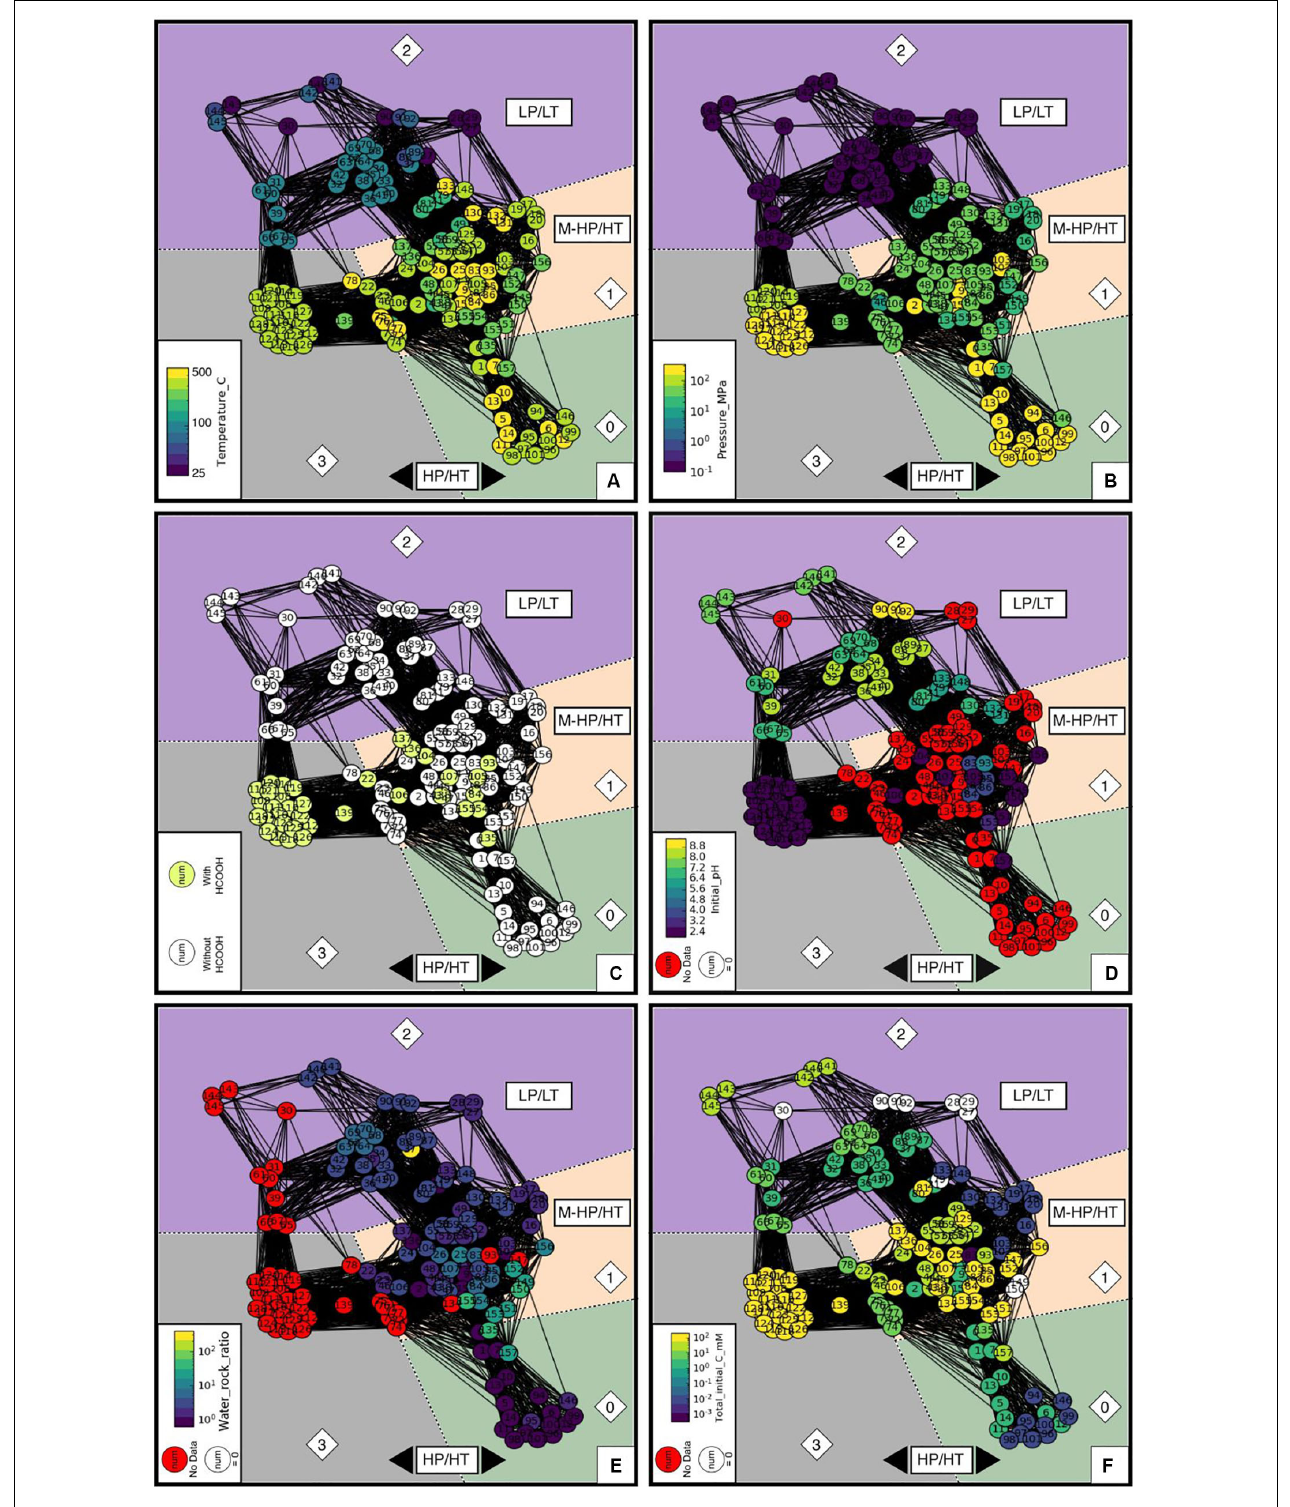
FIGURE 6 | Values of the parameters that dominantly control the distribution of the data in four different communities of experiments: (A) temperature in ◦ C; (B) pressure in MPa; (C) presence or absence of formic acid in the starting aqueous solution, with or without HCOOH; (D) pH of the starting aqueous solution (Initial_pH); (E) relative amount of water and rock (Water_rock_ratio); and (F) the total initial carbon concentration in the starting aqueous solution by adding up all carbon species (Total_initial_carbon_mM). All red filled circles indicate that the value of the parameter is missing in the original article that presents the experiment.